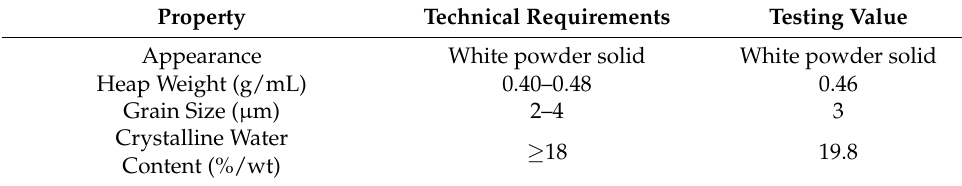
Table 3. Properties of XT-W3.